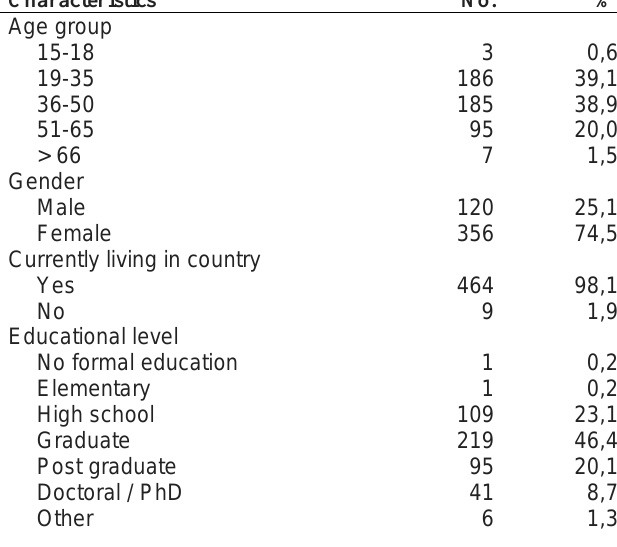
Table 1. Baseline characteristics of the MC sample